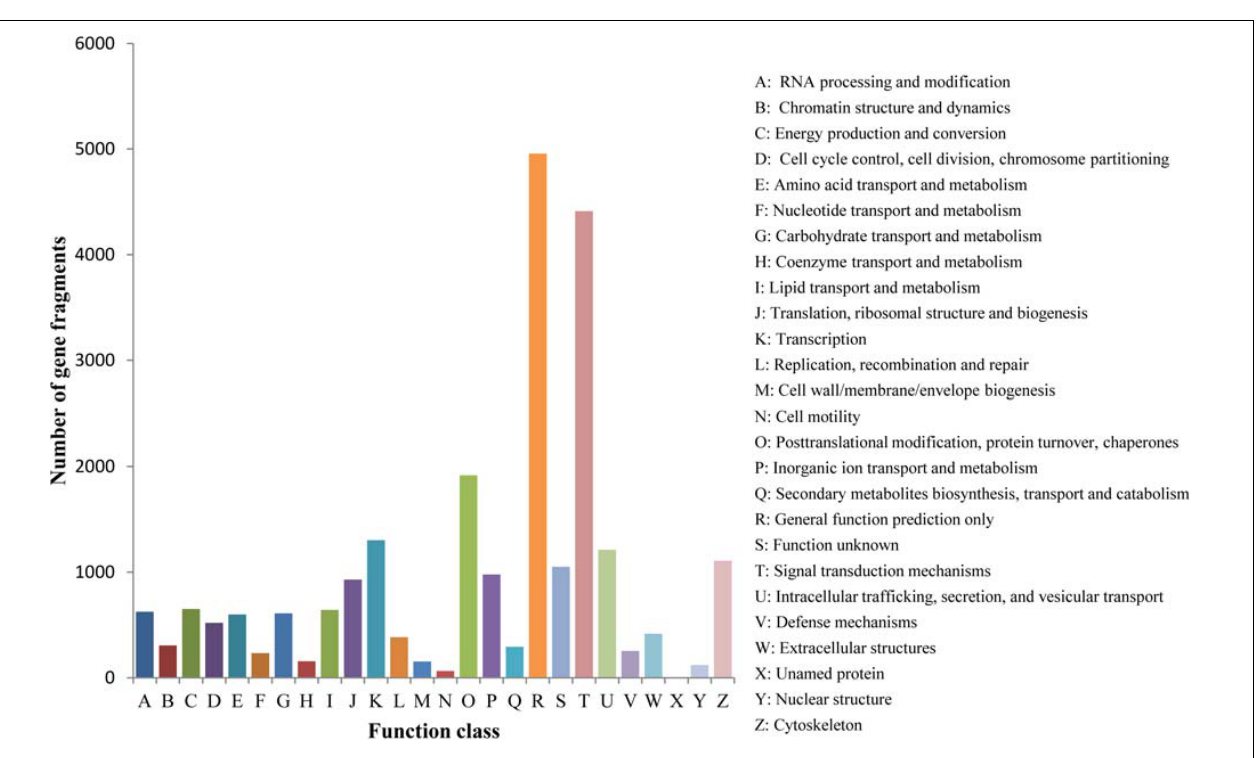
processes (3,548 sequences), and genetic information processing (2,555